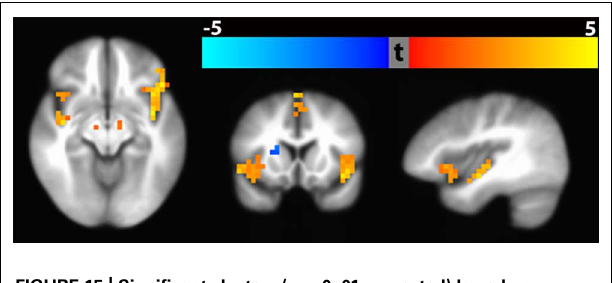
FIGURE 15 | Significant clusters ( p < 0. 01, corrected) based on baseline CBF difference between schizophrenic and healthy subjects using Path 3Voxel-wise Standard SpaceAnalysis. Bilateral clusters in the inferior frontal gyrus and parahippocampal gyrus are shown in the axial slice (hypoperfusion with Schizophrenia).The coronal slice shows hypoperfusion in the inferior frontal gyrus and hyperperfusion in the right putamen.The sagittal slice shows hypoperfusion in the anterior and posterior